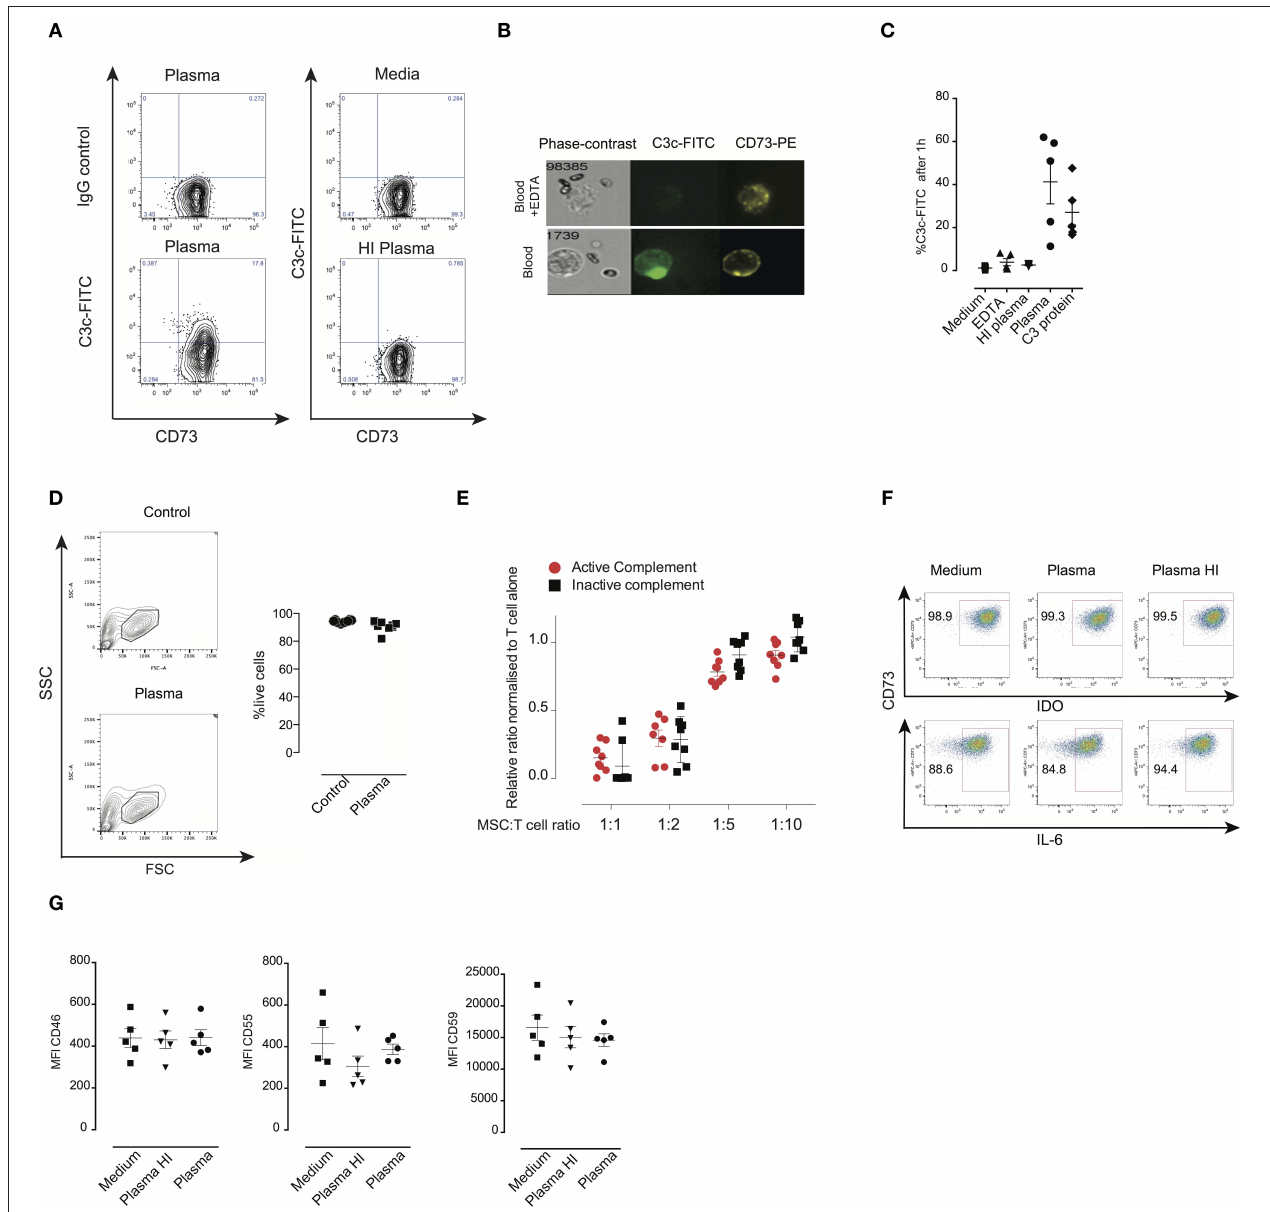
FIGURE 1 | Survival and function of MSC after their contact with plasma. (A) Contour plots from flow cytometry analysis of MSC stained with anti-C3c FITC or specific isotope control to detect C3b/iC3b deposition after exposure to plasma, heat inactivated (HI) plasma or untreated MSC. (B) FlowSight images of MSC incubated with blood compounds in the presence or absence of 10mM EDTA for 30min. MSC were stained with C3c-FITC and CD73-PE. Brightfield image of MSC is shown in the left part of the image. (C) Percentage of C3c-FITC binding to MSC after exposure to different conditions (media, EDTA-plasma, HI-plasma, plasma, purified C3 protein) for 1h. (D) Representative contour plot showing FSC and SSC of MSC after their exposure to plasma. Bars represent percentage of live (aqua live dead negative) MSC after 1h incubation in control vs. plasma from two different experiments. Data shown are representative of two experiments of five different MSC. (E) Inhibition of proliferation of 5 days activated T cells ( n = 3) in the presence of MSC ( n = 7) at the indicated ratios. Data shown are means and SD of two independent experiments. (F) Intracellular IDO or IL-6 expression was measured by flow cytometry in MSC exposed to control media, inactive complement plasma ( + EDTA, 10mM) or active complement plasma for 1h, thereafter washed and treated with TNF- α and IFN- γ for 72h. Data shown are representative from four MSC. (G) Expression of complement regulatory proteins CD46, CD55, and CD59 on MSC cultured in complete medium, HI plasma or plasma was analyzed by flow cytometry. Mean fluorescent intensities of MSC from five MSC in two different experiments are displayed with mean and